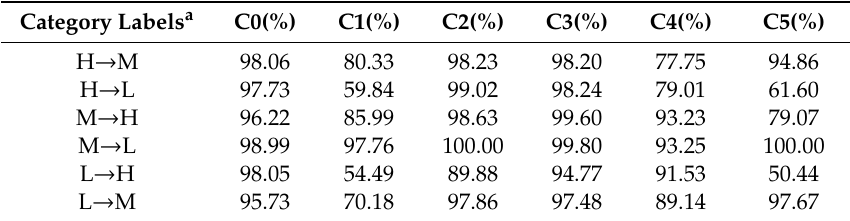
Table 3. Precision of the proposed GTL method.